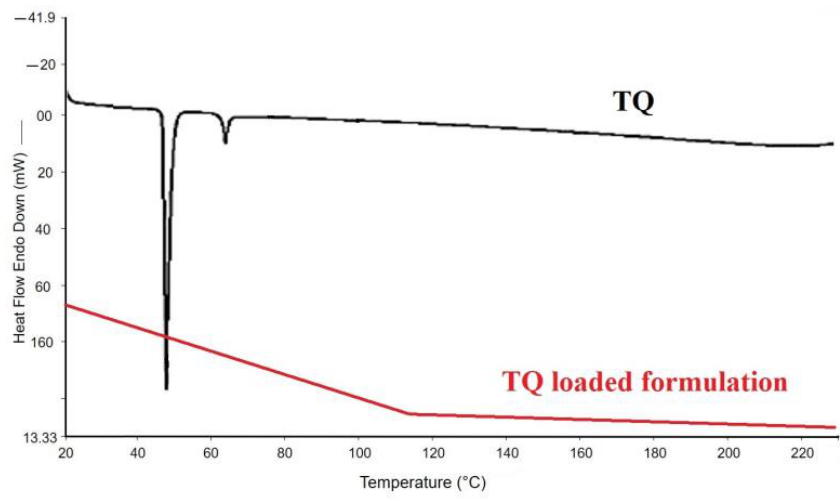
Figure 2. DSC curves of pure thymoquinone (TQ) and freeze-dried TQ-loaded liposomal formulation (batch 2).